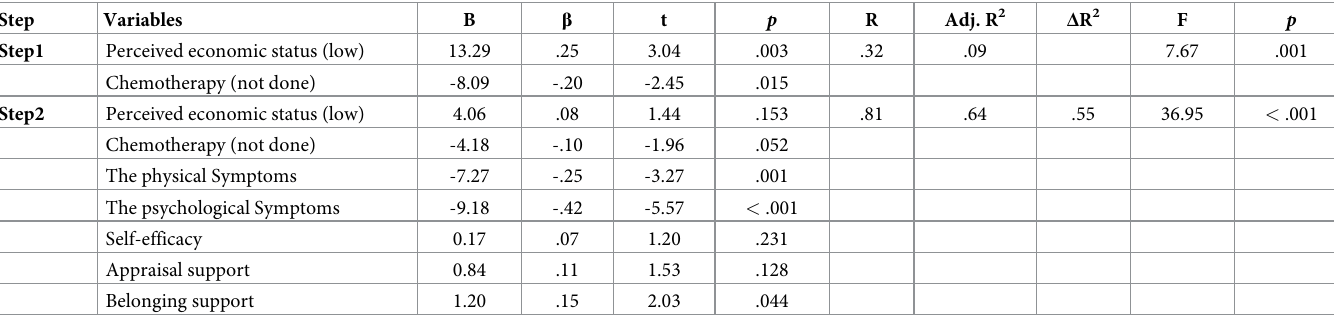
that significantly correlated with QOL in the univariate analysis, were introduced. In the sec- ond regression (Step 2), symptom experience, self-efficacy, appraisal support, and belonging support were introduced to analyze the influence of these factors on QOL. In the first stage (Step 1) of the two-stage hierarchical multiple regression, perceived eco- nomic status and chemotherapy explained a significant amount of the variance in QOL ( p = .001, Adj R 2 = .09). In the second stage (Step 2), physical symptoms, psychological symptoms, self-efficacy, appraisal support, and belonging support explained approximately 64% of the variance in QOL. Of these, physical symptoms ( β = -.25, p = .001), psychological symptoms Table 4. Determinants of the quality of life in the study participants (N =